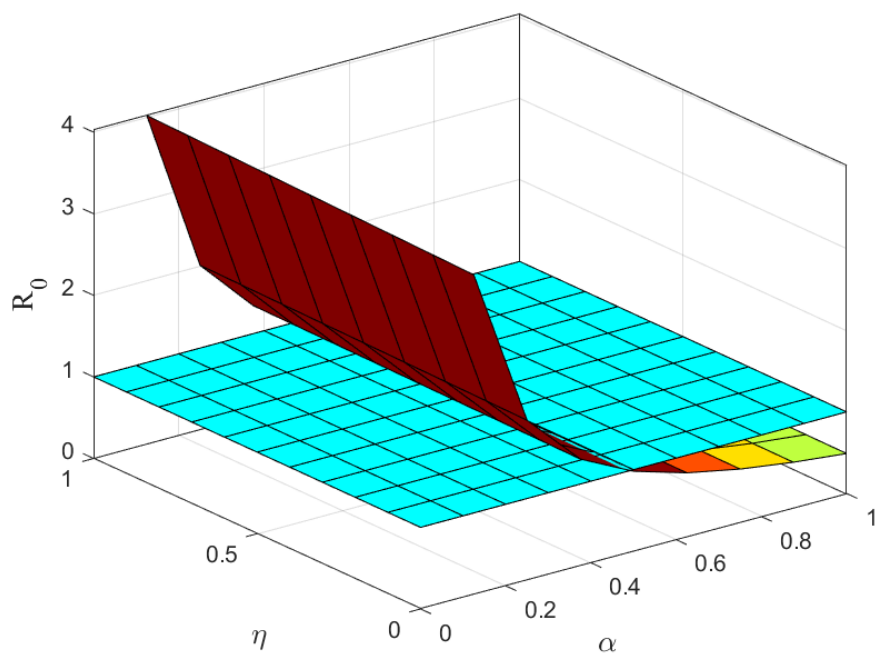
Figure 6. The relationship among α , η , and R 0